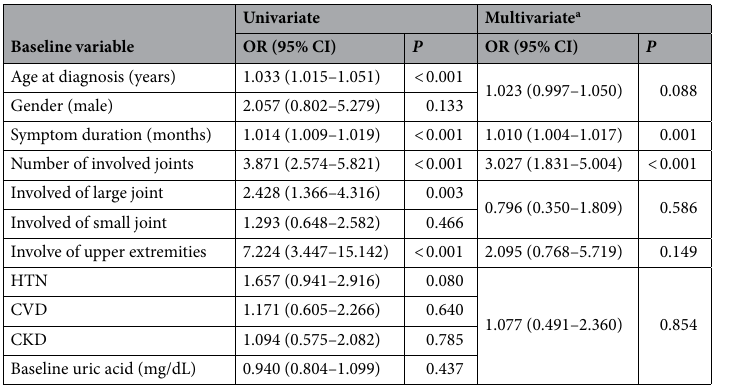
Table 3. Logistic regression analysis for the presence of tophi in study subjects. OR odds ratio, CI confidence interval, HTN hypertension, CVD cerebrovascular disease, CKD chronic kidney disease. a Adjusted for age at diagnosis, symptom duration, number of involved joints, involved of large joint, involve of upper extremities, and HTN.